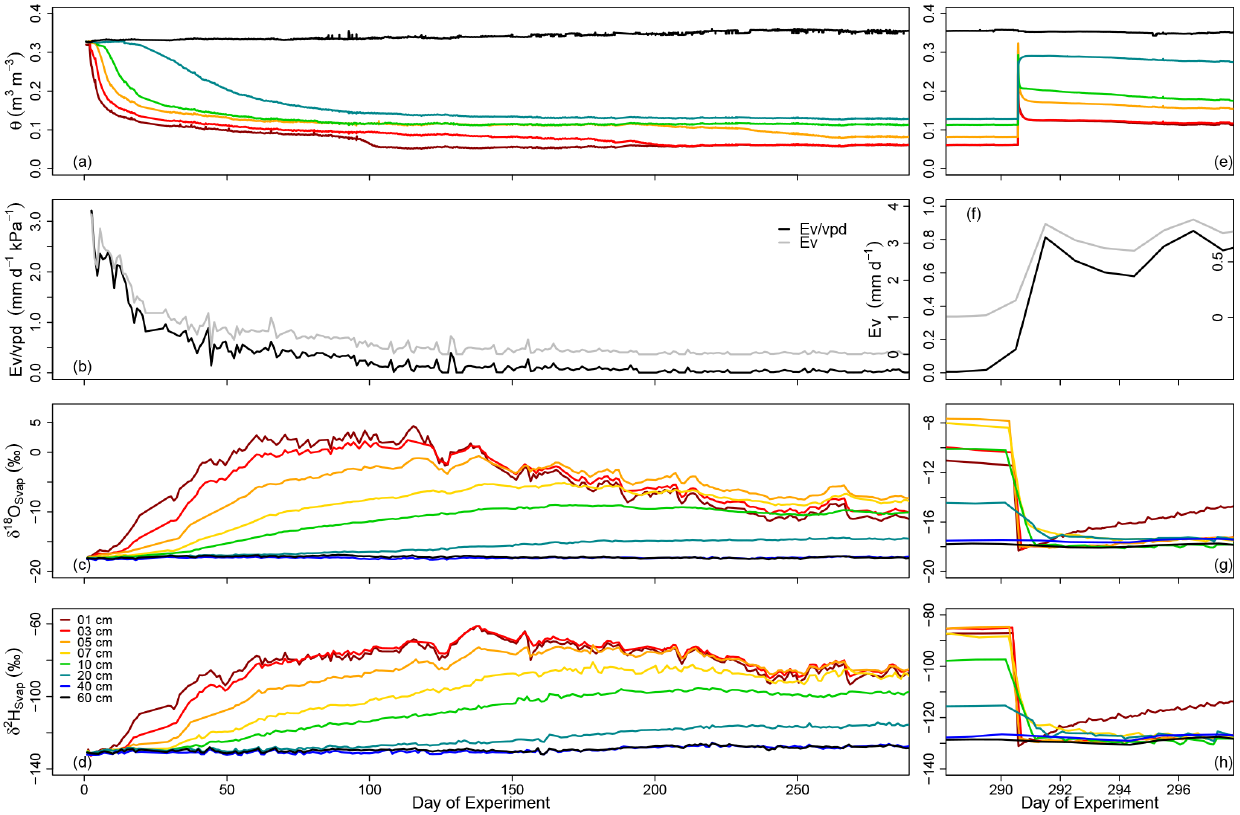
Figure 4. Time series of water content ( θ ), evaporation flux (Ev), evaporation flux normalized to vapor pressure deficit (Ev/vpd), and water vapor isotope compositions ( δ 18 O Svap and δ 2 H Svap [‰ VSMOW]) during the course of the